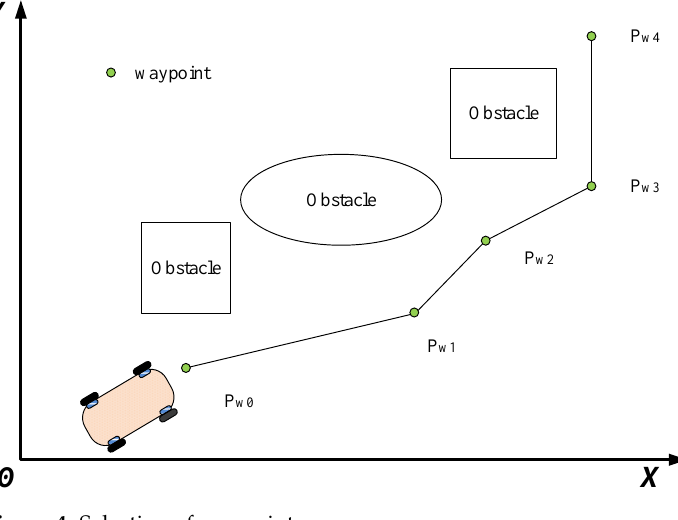
Figure 4. Selection of waypoints.